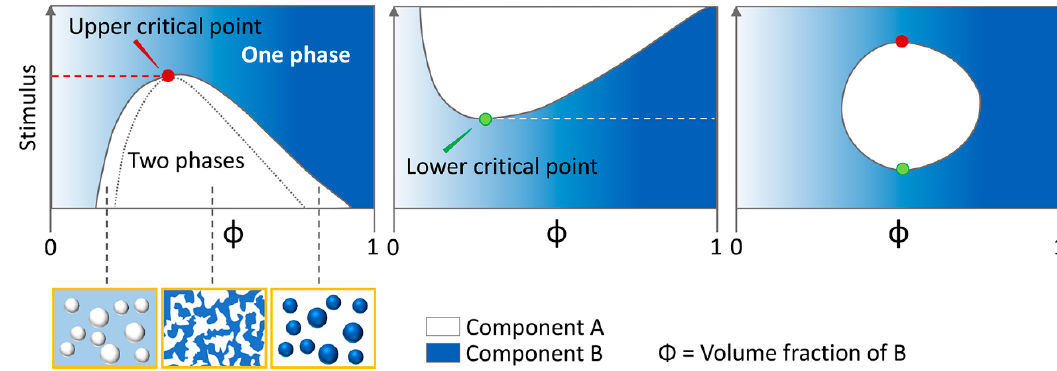
Figure A2. A two-component mixture can give rise to a single-phase well-mixed system, or to a two-phase system, in which the two components are separated. The separation into two phases can occur below or above a critical value of temperature, pH, ionic strength, etc. The diagram illustrates the coexistence curve (binodal) of three reference systems in response to a generic stimulus. ( Left side ): the transition can occur below a threshold point, which is therefore called the upper critical point (UCP). Phase separation is only observed upon a rate-limiting nucleation event, under conditions lying in between the binodal (indicated as solid line) and spinodal curves (indicated as dotted line). Once the spinodal curve is crossed, nucleation becomes dispensable and phase separation spontaneously occurs by spinodal decomposition. The pictorial schemes in the yellow boxes show spinodal decomposition (in the middle) and de-mixed states of components A and B (left and right); ( Middle ): phase separation occurs beyond the lower critical point (LCP); ( Right side ): this system features both UCP and LCP